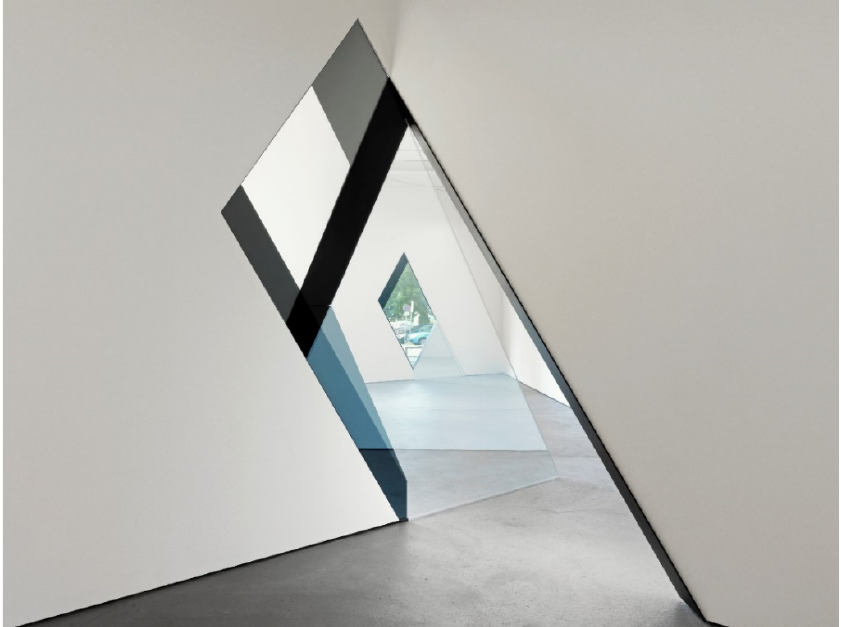
Fig. 12 33-D, 2014 | Aluminum, glass and existing architecture | Total dimensions variable | Location: Kunsthaus Baselland Photo Credit: Serge Hasenböhler